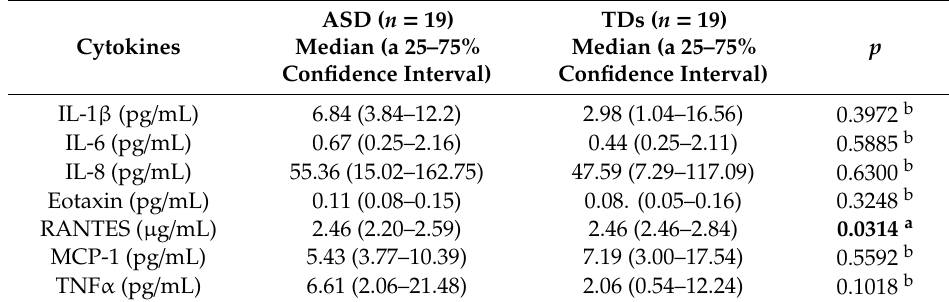
Table 4. Comparison of IL-1 β , IL-6, IL-8, RANTES, eotaxin, MCP-1, and TNF α salivary levels between the ASD and TD groups.